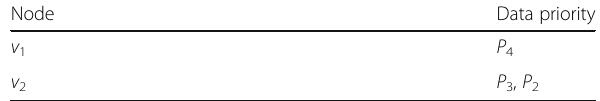
Table 2 The priority levels of data of each node in network 1